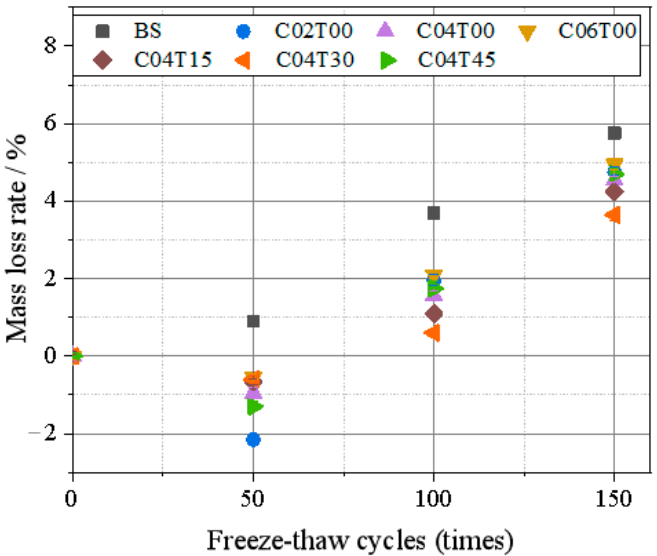
Figure 5. Mass loss rate of cement-based composites under freeze-thaw cycles.